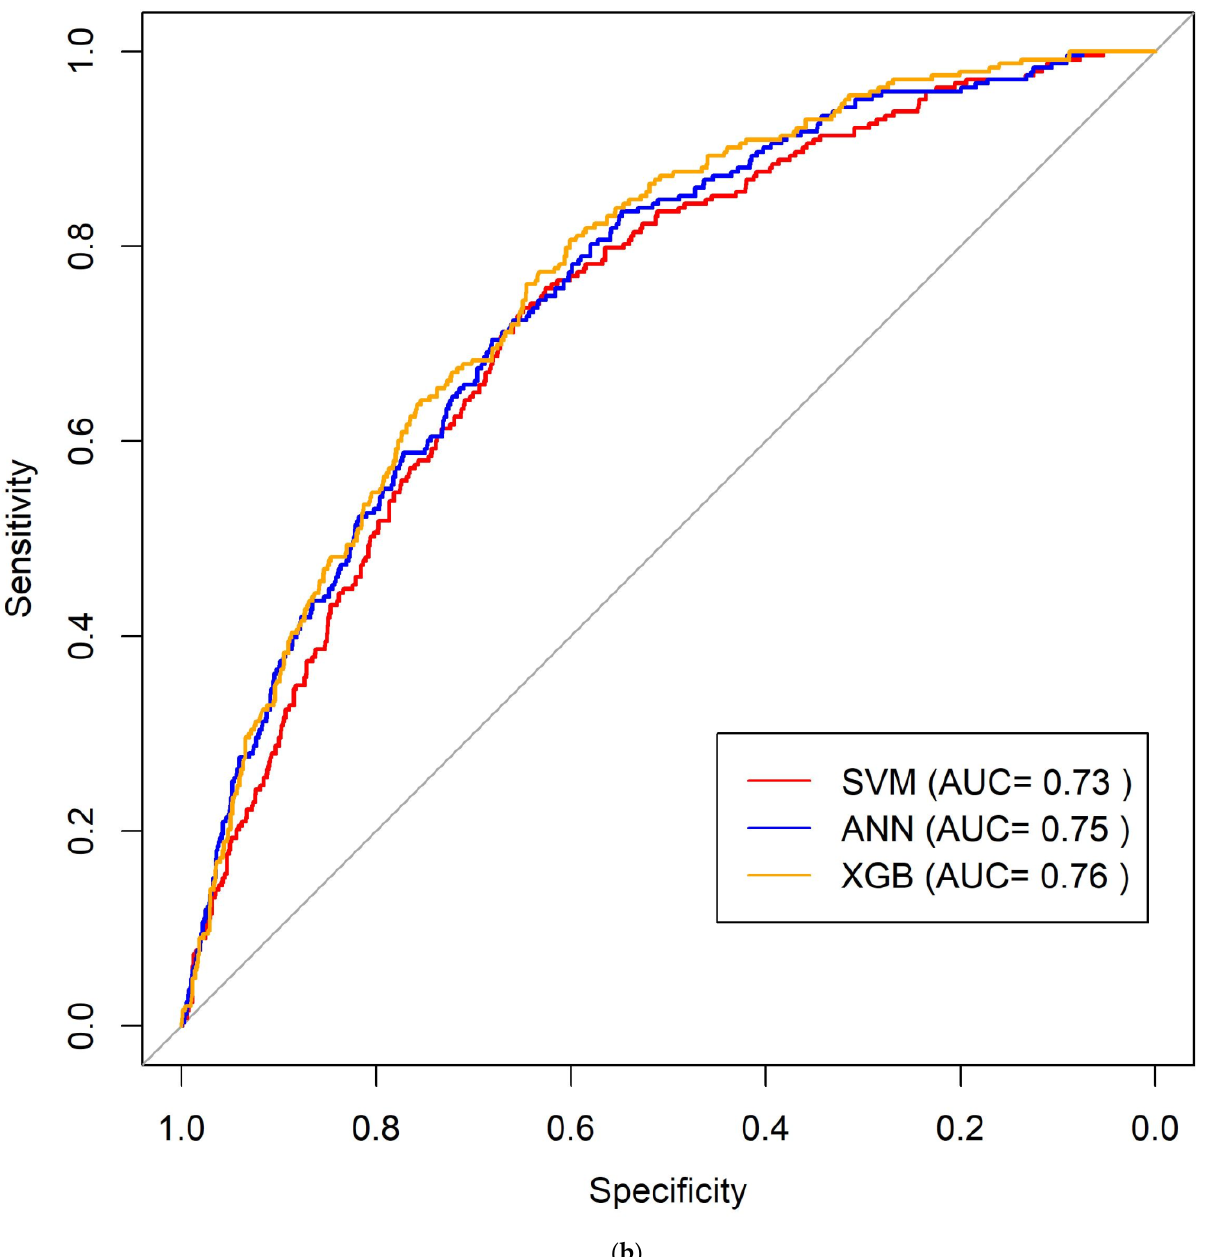
Figure 1. ( a ) Prediction of dementia using 38 biomarkers. ( b ) Prediction of dementia using the 9 most informative biomarkers.